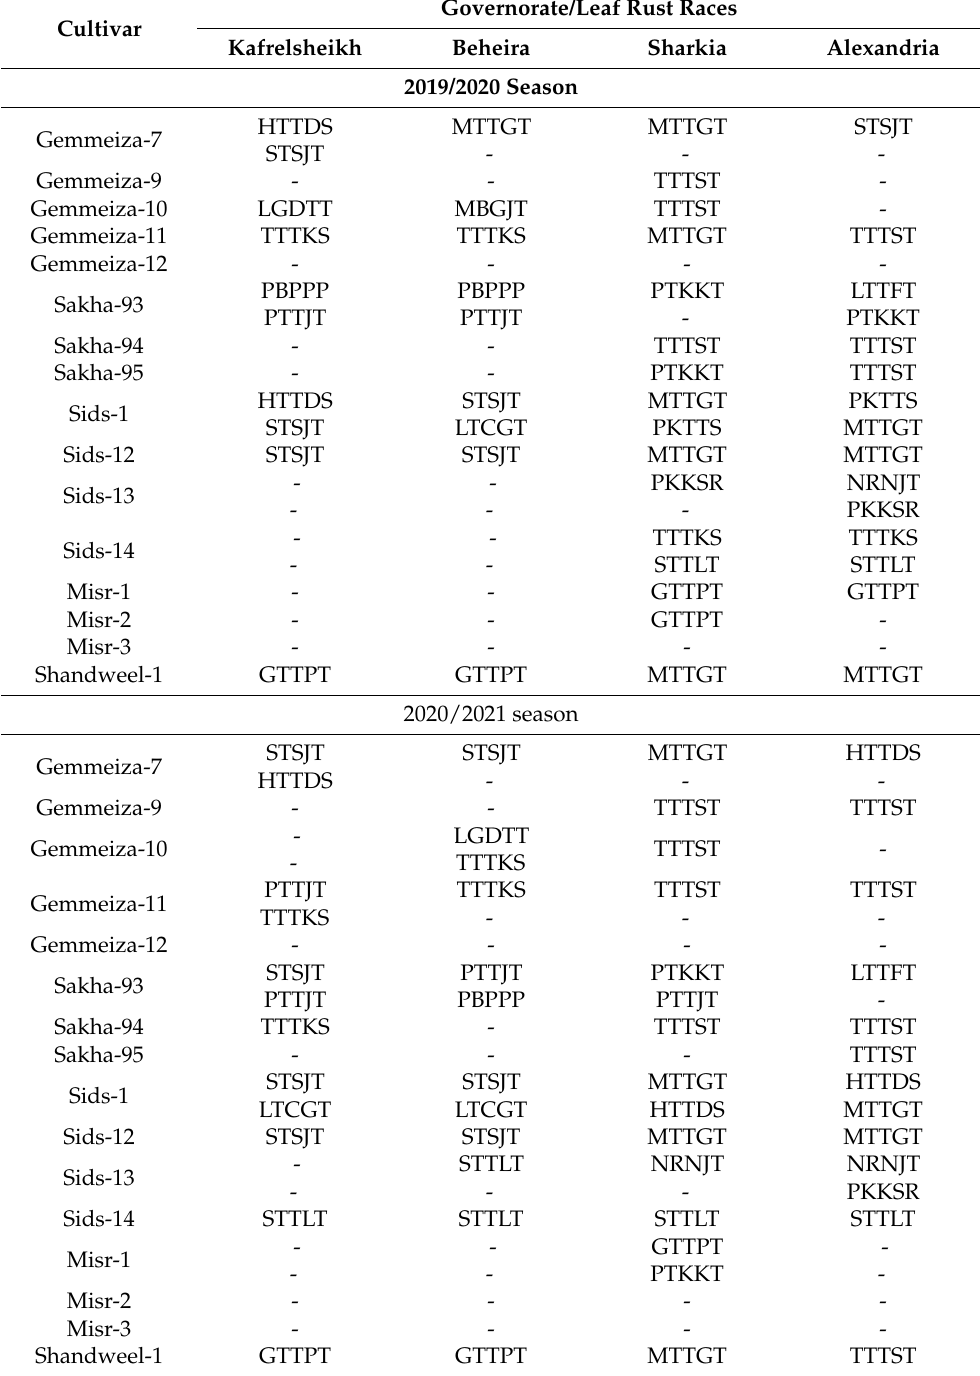
Table 5. Physiological leaf rust races identified in the Egyptian wheat cultivars, in different gover- norates, during 2019/20 and 2020/21 growing